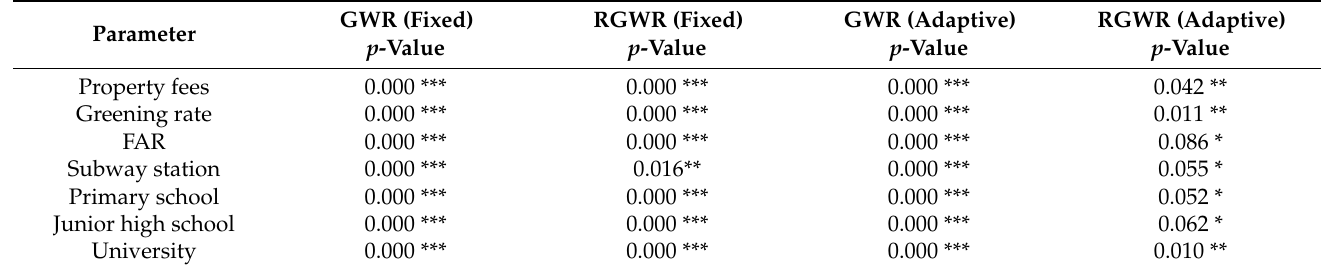
Table 3. The spatial non-stationary characteristic test of the RGWR and GWR model.